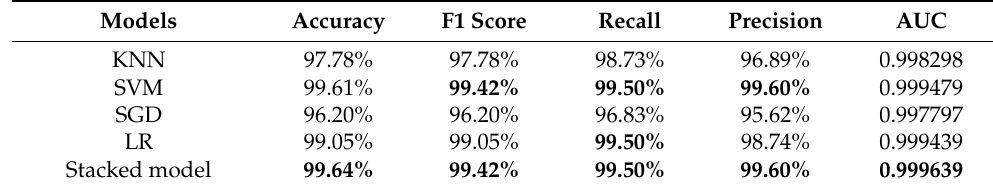
Table 2. Comparison of prediction performances between the stacked model and its component base classifiers’